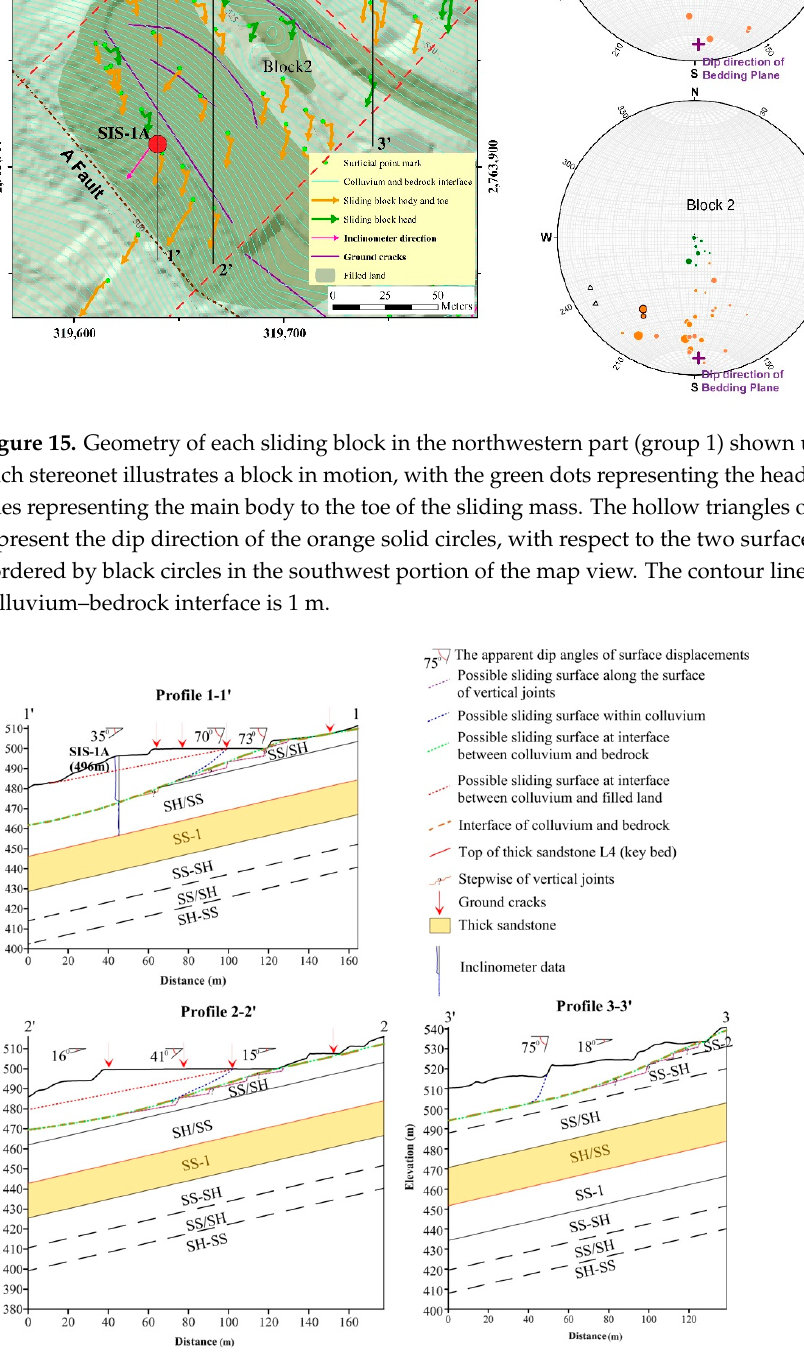
Figure 16. Cross-sectional profiles with potential sliding surfaces in the western part of the campus. Geological profiles are approximately parallel to the vectors representing the horizontal surface displacement (see Figure 15).